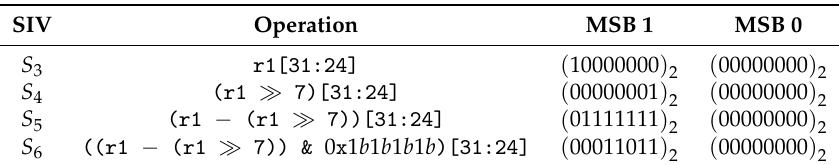
Table 4. Binary representation of the first byte of the SIVs for each operation when performing xtime in OpenSSL aes_x86core.c